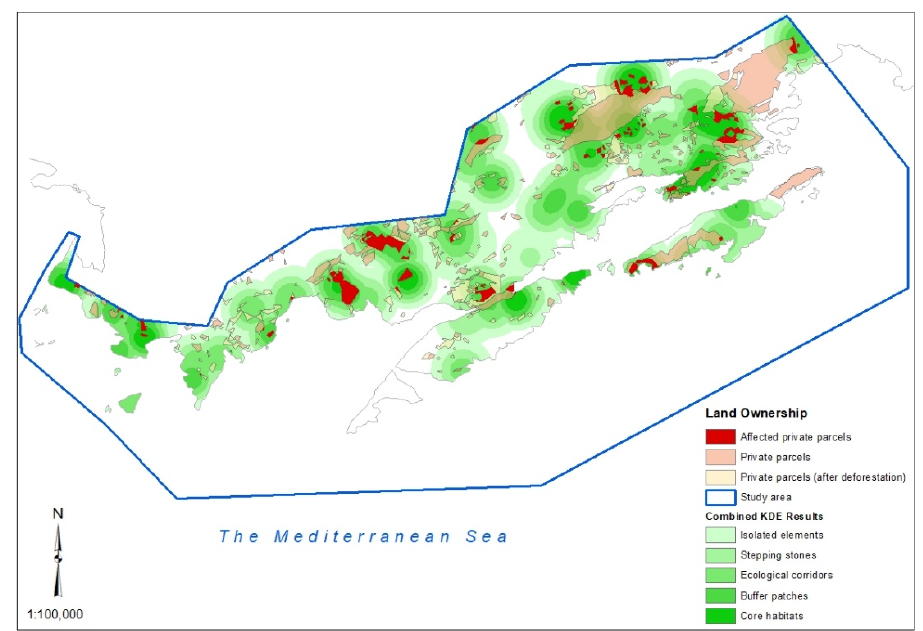
Figure 13. Cadastral analysis results and the determined habitat network. Table 6. The percentages of different ownership types in the PA.